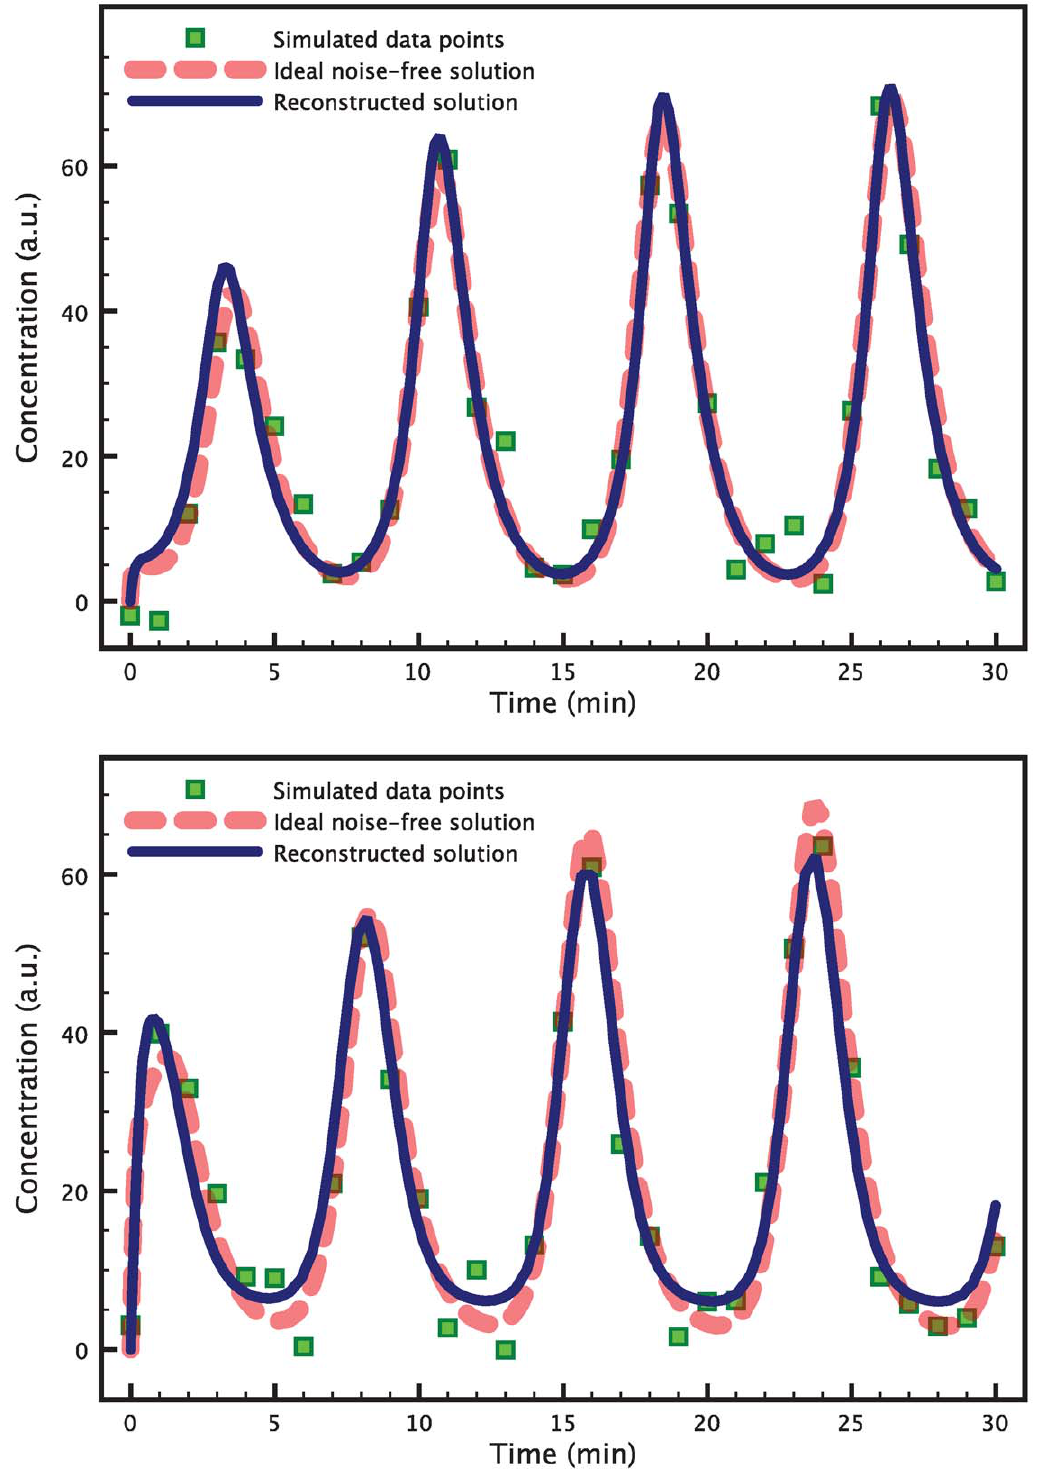
Figure 7. Estimation of 18 parameters in the repressilator model. The data points (green squares) are obtained by evaluating the true model solution (red dashed curve) at the chosen time points, and then adding white Gaussian noise. The blue solid line shows the reconstructed solution corresponding to the estimated parameters. Both the reconstructed measurement signal for m 1 (top) and the one for m 2 (bottom) are very close to the respective true solutions. The graph for the measurement m 3 is presented in the supporting Figure S1.